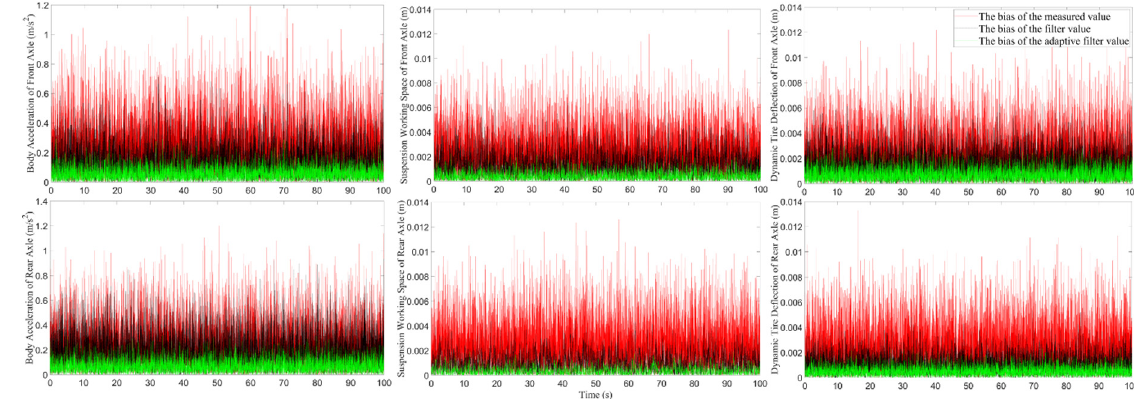
Figure 16. Biases of measurable performance indexes. Table 6. Kalman filter bias values of measurable performance indexes.